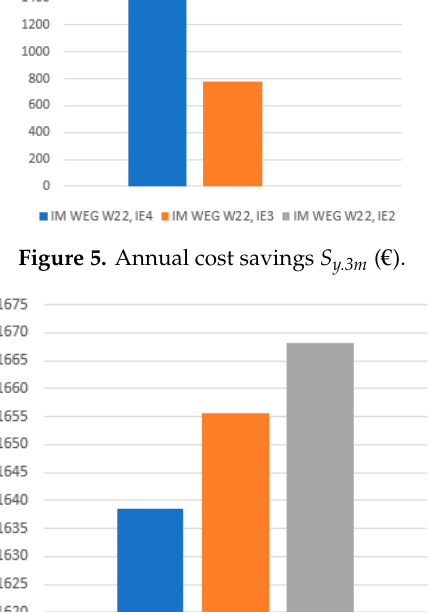
Figure 6. Electricity lifecycle cost C LCCen.m (k € ).